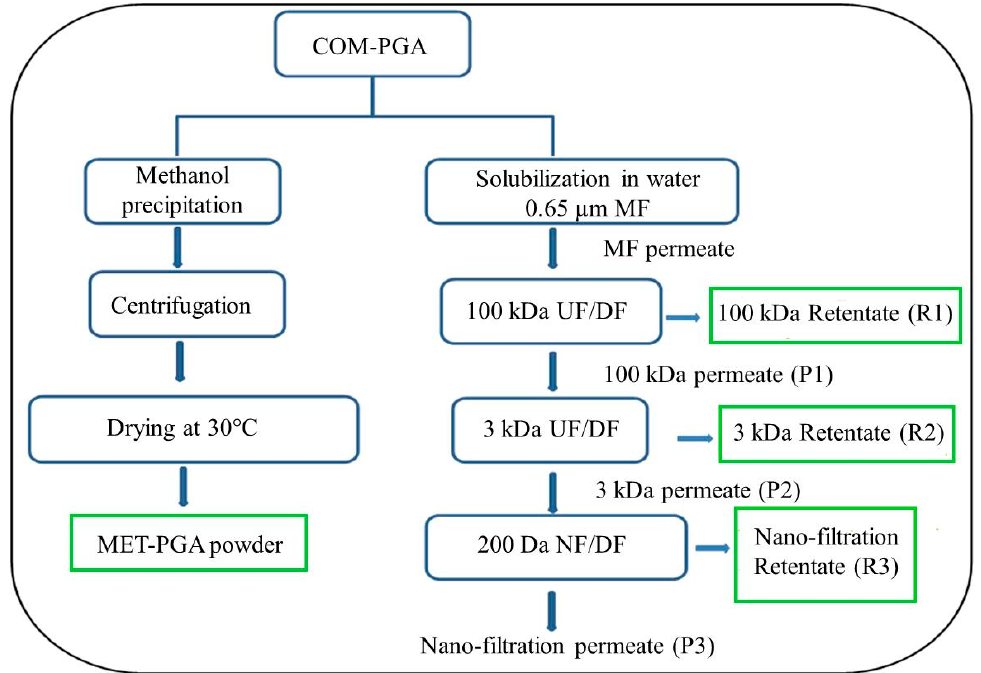
Figure 1. Flowchart of the processes for obtaining partially purified γ -PGA from COM-PGA by methanol precipitation (MET-PGA powder) or low Mw fractions of the homopolypeptide by membrane-based purification by micro-filtration (MF), ultra-(UF)/dia-filtration (DF) and nano-filtration (NF). The main γ -PGA fractions (MET-PGA powder, R1, R2 and R3), here reported in the green boxes, were then characterized and assayed for their properties.